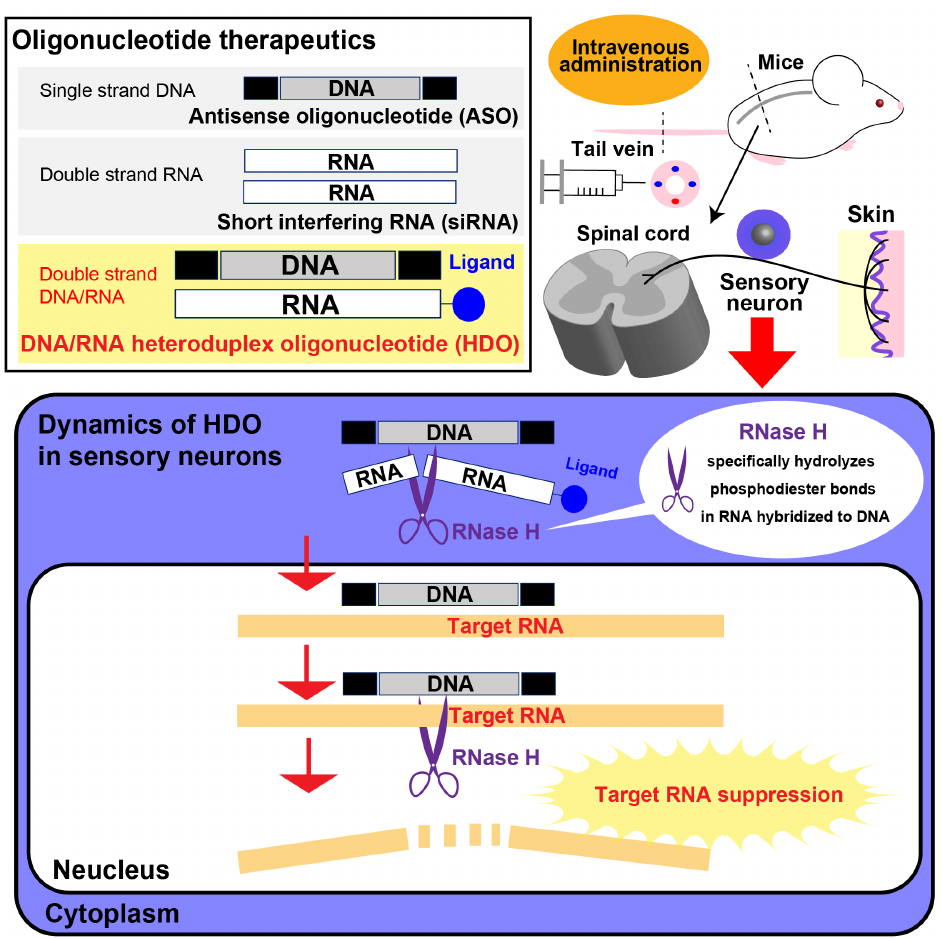
Figure 3. Schematic representation of oligonucleotide therapeutics and their mechanisms. HDO suppresses target RNAs. It is a double-stranded artificial functional nucleic acid consisting of a DNA strand as the main strand and an RNA complementary to the main strand, which is called a “gapmer” nucleic acid (LNA). This part is recognized by RNase H, an enzyme that degrades RNA in the cell, and the complementary strand RNA is cleaved. The resulting single main strand binds to the target RNA, and RNase H again cleaves the target RNA to exert its gene suppression effect.